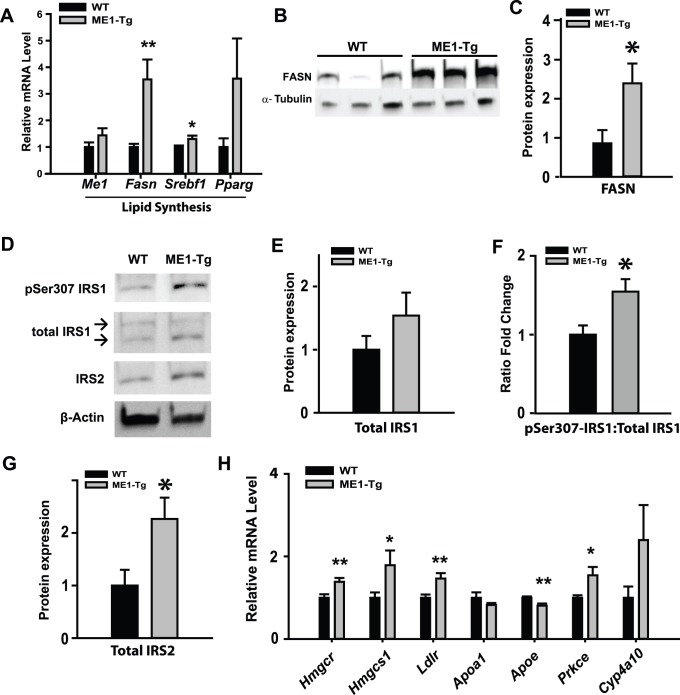
Expression of lipogenic pathway and cholesterol synthesis pathway genes in livers of WT and ME1-Tg mice fed HF diet.A) qRT-PCR analysis of major lipogenic pathway genes in livers of WT and ME1-Tg mice fed HF diet (Exp. 2; n = 8−9/group). B) Western blot of FASN protein in livers of WT and ME1-Tg mice fed HF diet. C) Densitometric analysis of immunoreactive bands in (B) relative to α-Tubulin protein. D) Western blot of IRS1, pSer307-IRS1, and IRS2 in livers of WT and ME1-Tg mice fed HF diet (n = 5/group). E–G) Densitometric analysis of immunoreactive bands of total liver IRS1 (E) and IRS2 (G) and the relative ratio of immunoreactive pSer307-IRS1/total IRS1 band densities (F). H) mRNA expression of select cholesterol synthesis- and cholesterol uptake-related genes in the livers of WT and ME1-Tg mice (Exp. 2; n = 8−9/group). qRT-PCR reactions were repeated twice in all experiments (A, H). Bar graphs represent mean ± SEM. Significant differences at *P<0.05 and ** P<0.01 between genotypes.